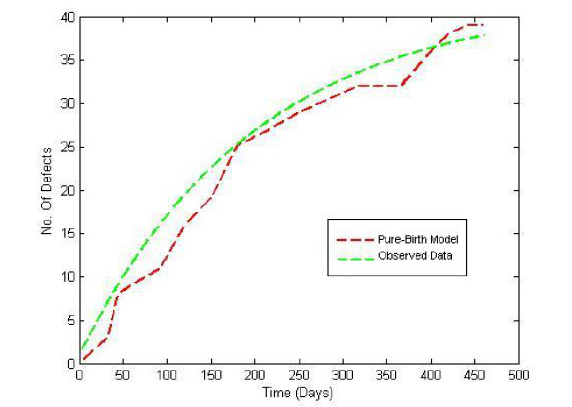
Fig. 4. Prediction of software